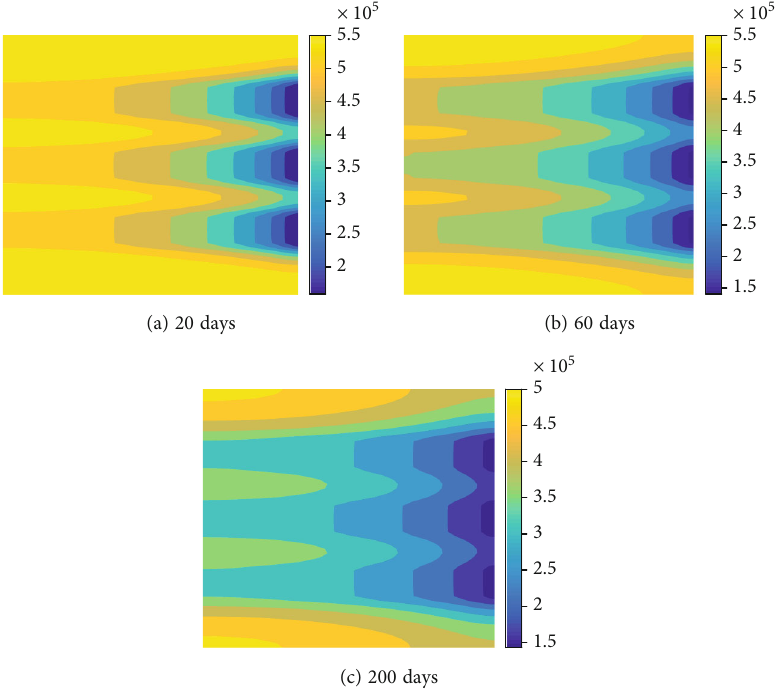
= 40 mol/m 3 at di ff erent b